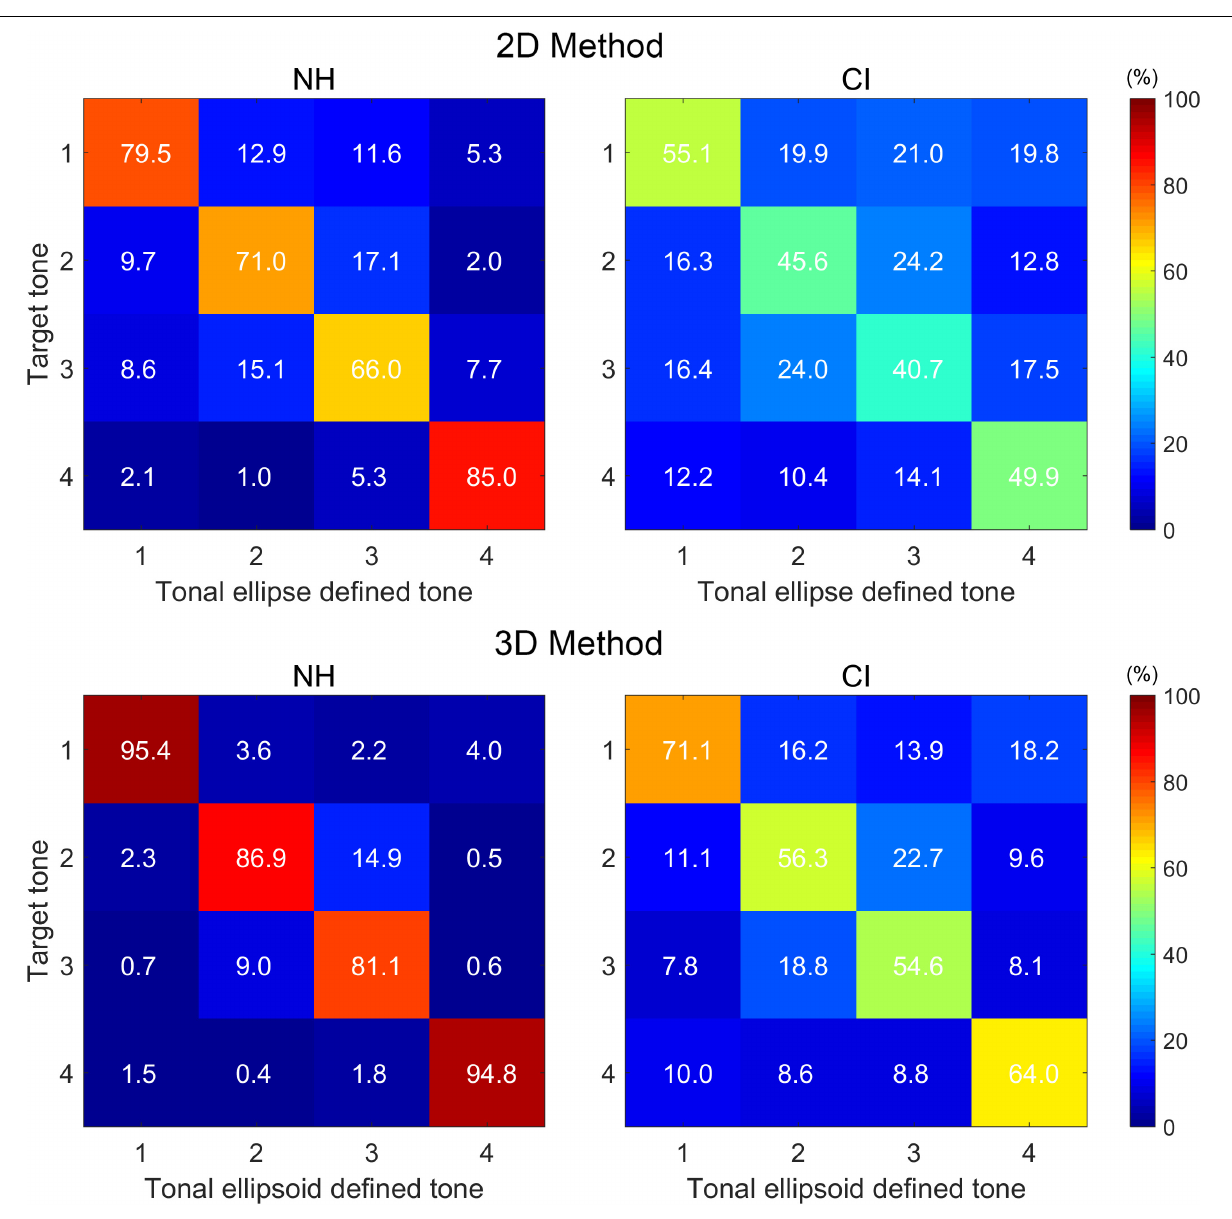
FIGURE 4 | Tone hit-rate confusion matrices of the two groups based on the 2D (upper panels) and 3D methods (lower panels) . Data were averaged values of all subjects in each group. For each panel of 4 × 4 cells, the columns represent the tone categories defined by the tonal ellipses or the tonal ellipsoids (i.e., within the tonal ellipses or ellipsoids), whereas the rows represent the target tone categories. Value in the cell of row i and column j is the proportion of target tone i inside tonal ellipse (or ellipsoid) j ( i = 1, 2, 3, or 4; j = 1, 2, 3, or